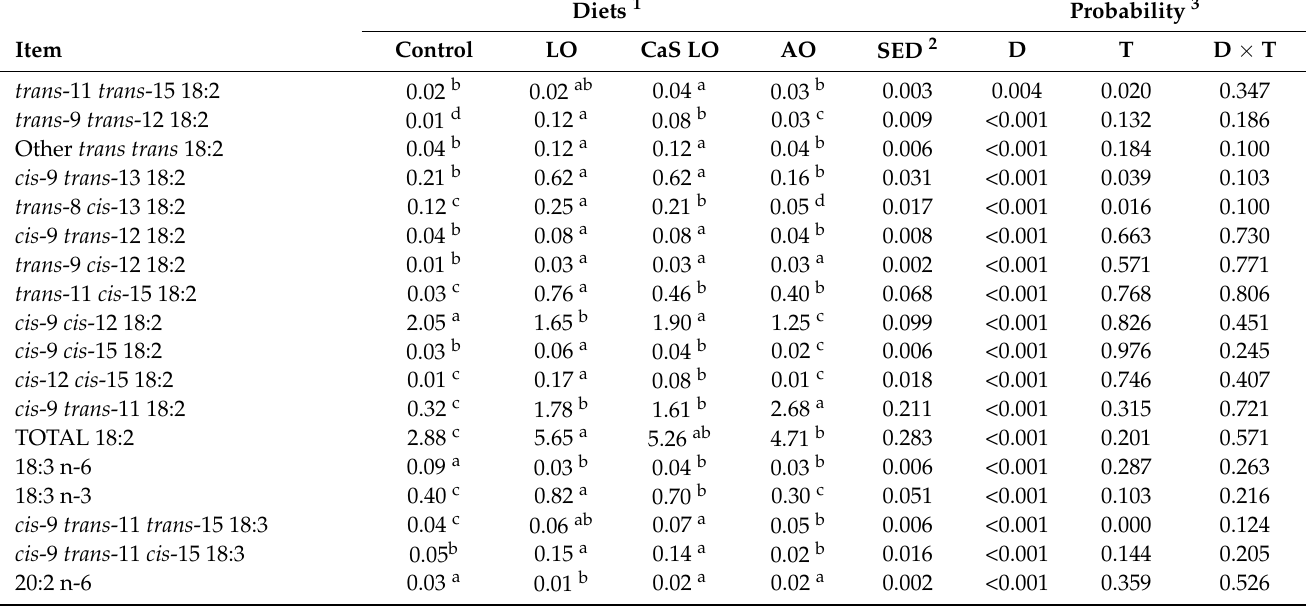
Table 5. Polyunsaturated fatty acid (PUFA) profile (g/100 g of total fatty acid methyl esters) of milk fat from ewes fed with 2.3% of different lipid supplements. ALA ( α -linolenic acid); DHA (22:6 n-3); DPA (20:5 n-3); EPA (22:3